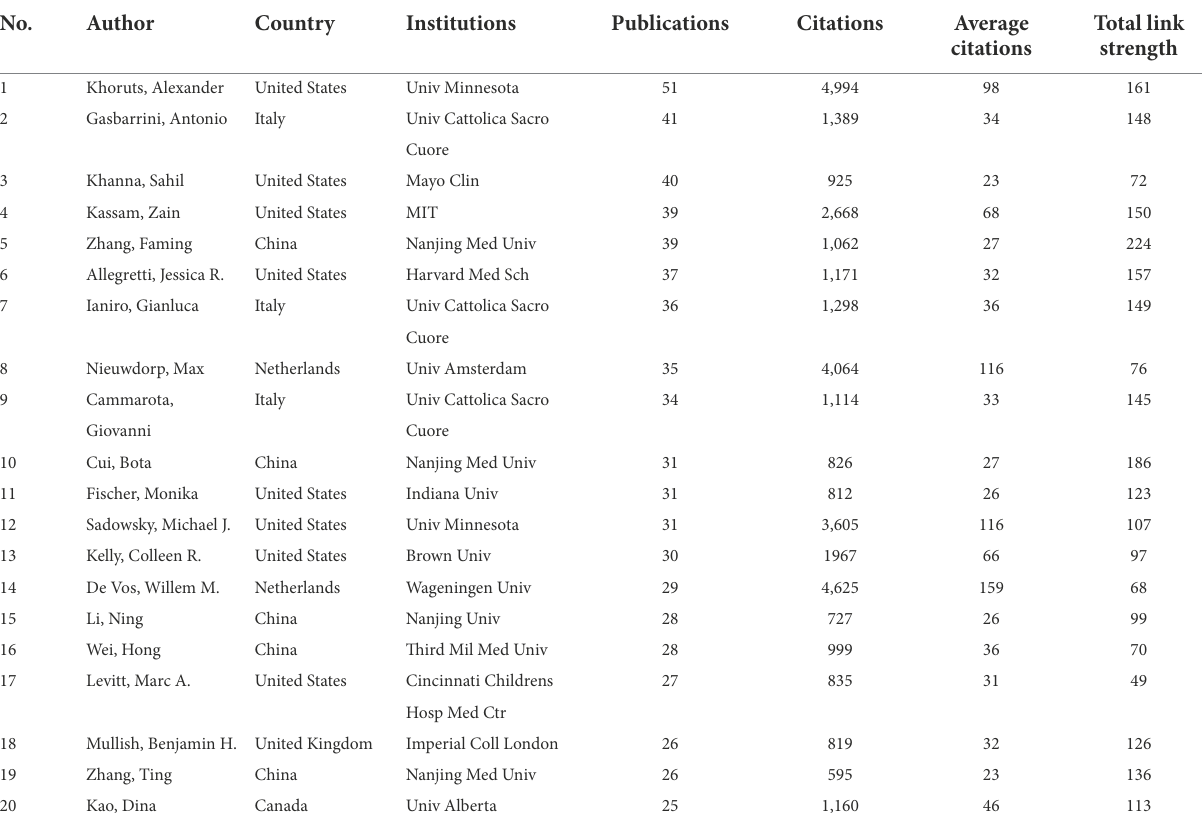
TABLE 3 The characteristics of the top 20 authors based on publications.